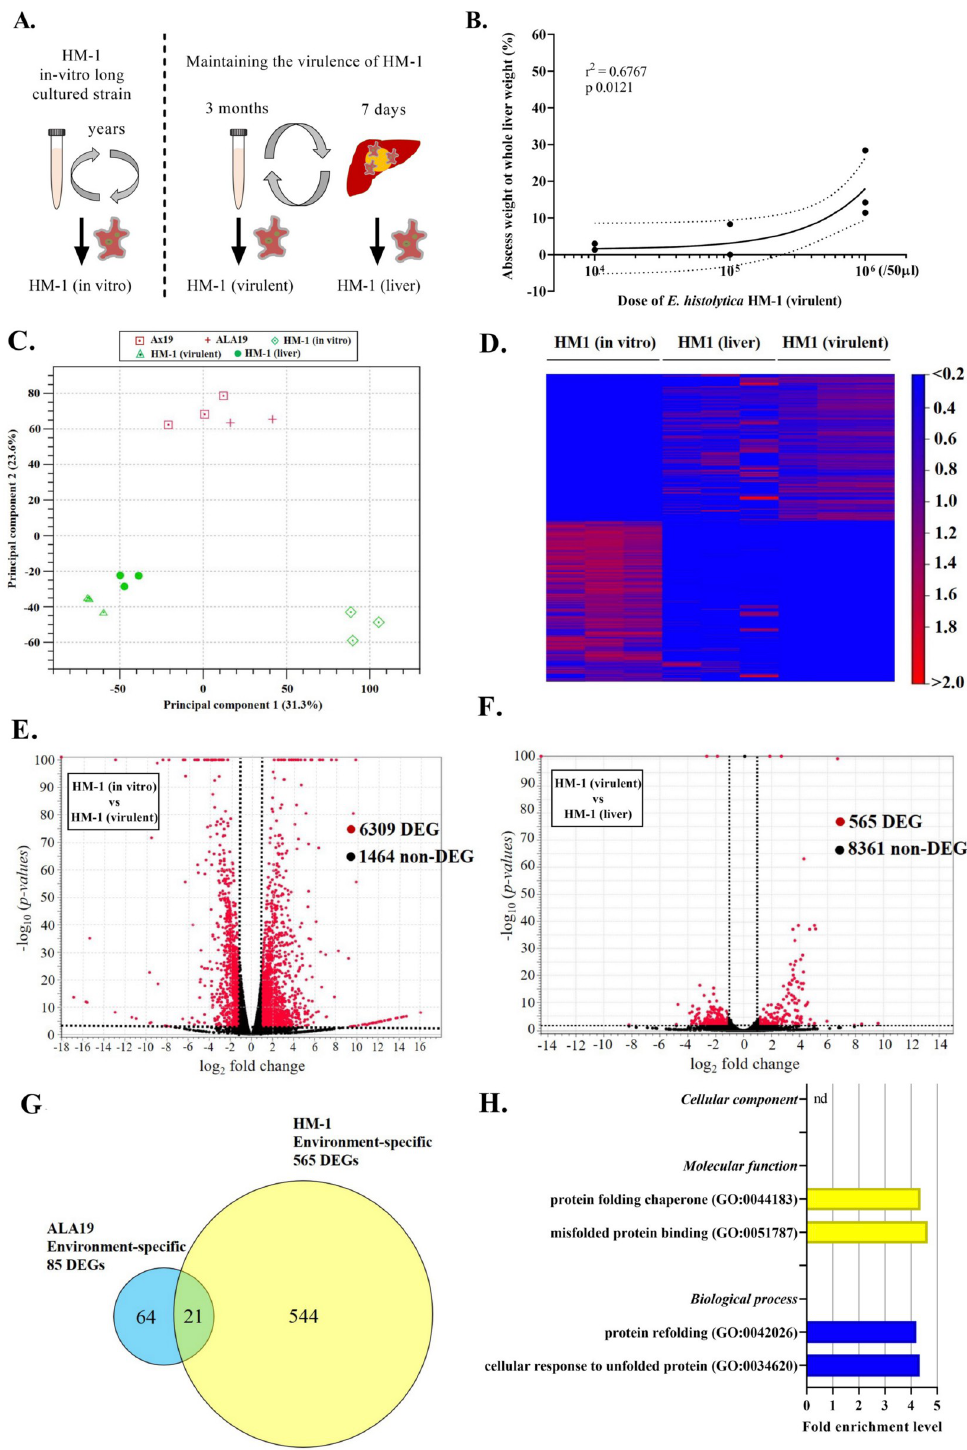
Fig 5. Transcriptome profiling of the E . histolytica laboratory strain (HM-1:IMSS clone 6). (A) Experimental work flow for the three different culture conditions: HM-1 ( in vitro ), maintained under in vitro culture conditions for many years; HM-1 (virulent), maintained under virulent conditions by routinely passaging through an animal liver every 3 months; HM-1 (liver), collected just after liver challenge with strain HM-1. (B) The proportion of liver abscess weight to whole liver weight for strain HM-1 (virulent). The proportion was positively correlated with the dose of HM-1 (virulent),